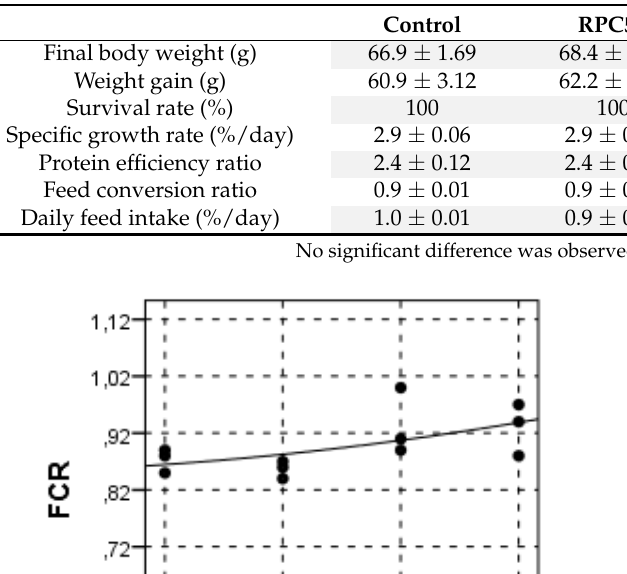
Table 4. Growth performance of rainbow trout juveniles after 12 weeks.